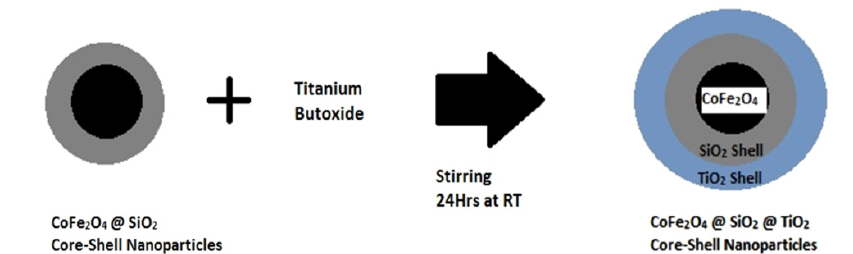
Figure 5. Reaction scheme for the coating of SiO 2 coated cobalt ferrite nanoparticles with a second TiO 2 coating.